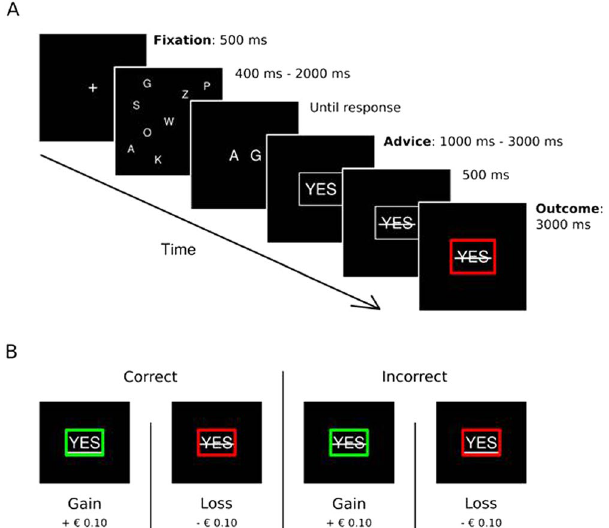
Figure 1. “I told you so” task. ( A ) Example of a correct trial with a negative outcome. ( B ) All 4 possible outcomes. The participant could be correct or incorrect in his/her advice and the outcome based on the co- actors decision could be a monetary gain or loss. If the co-actor agreed with the advice of the participant, the advice (‘YES’ or ‘NO’) was underlined. In case the co-actor disagreed with the advice, this was shown as a strikethrough. Gains were visualized by a green box, and losses by a red box. Incorrect final decisions resulted in a 10 eurocents loss, and correct trials were rewarded by a 10 eurocents